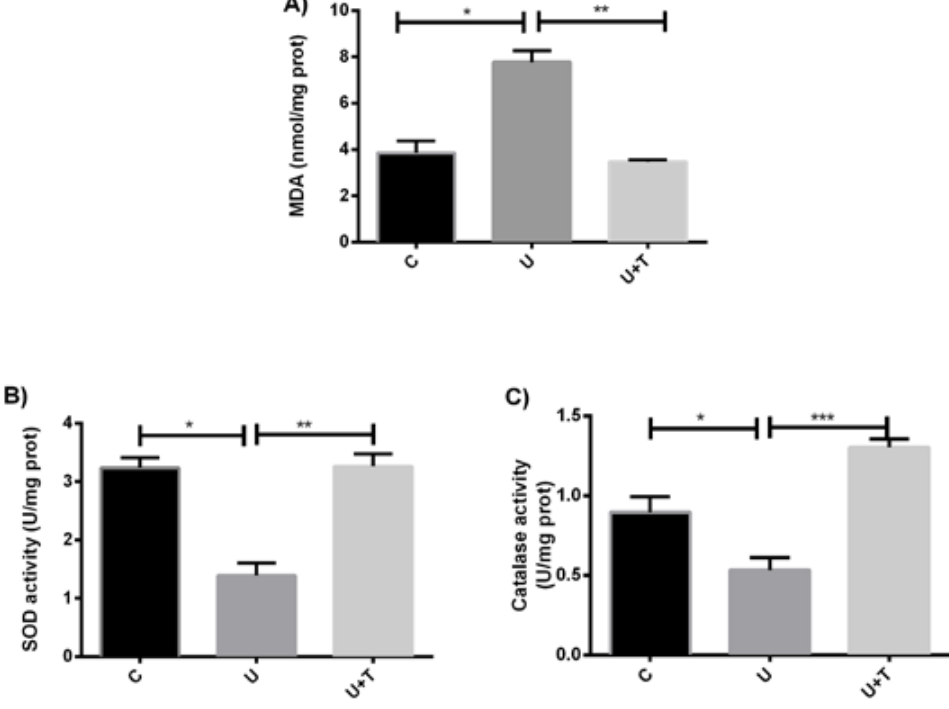
Figure 2: Effect of maternal low-protein diet and moderate physical training on cardiac oxidative stress. Lipid peroxidation evaluated by MDA levels (A) Antioxidant enzymatic defense, Superoxide dismutase activity (B) and catalase activity (C) in male offspring at 120 days of life. C= Control group; U= undernourished group; U+T= undernourished plus 8 weeks of moderate physical training group. Data are shown as mean + SEM for 4-6 animals per group. * p <0.05; ** p <0.01; *** p